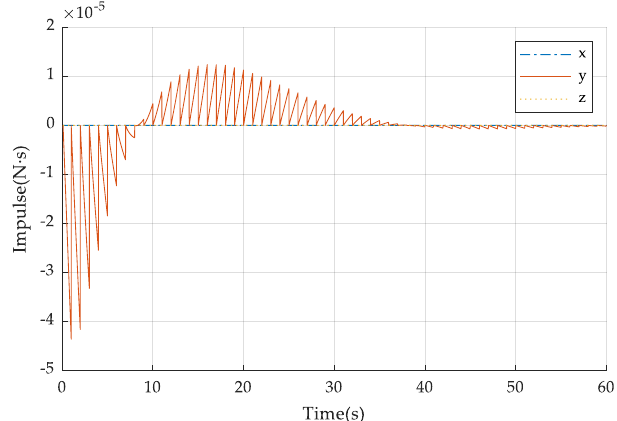
Figure 12. Periodic total impulse curve.